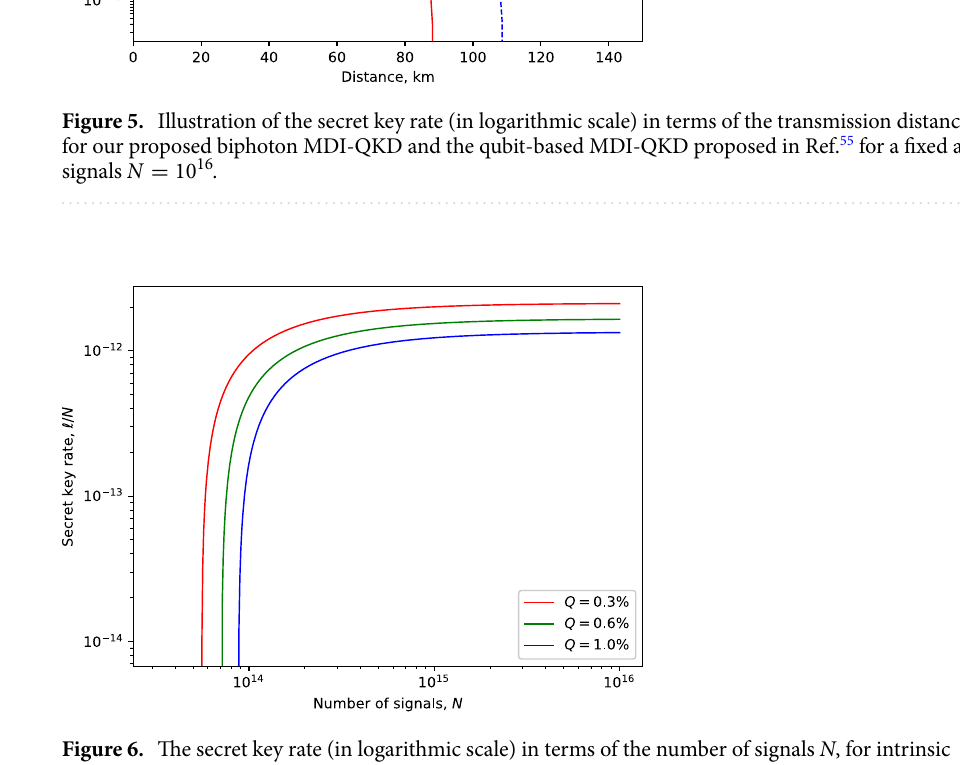
Figure 6. The secret key rate (in logarithmic scale) in terms of the number of signals N , for intrinsic misalignment errors 0.3% , 0.6% , and 1%